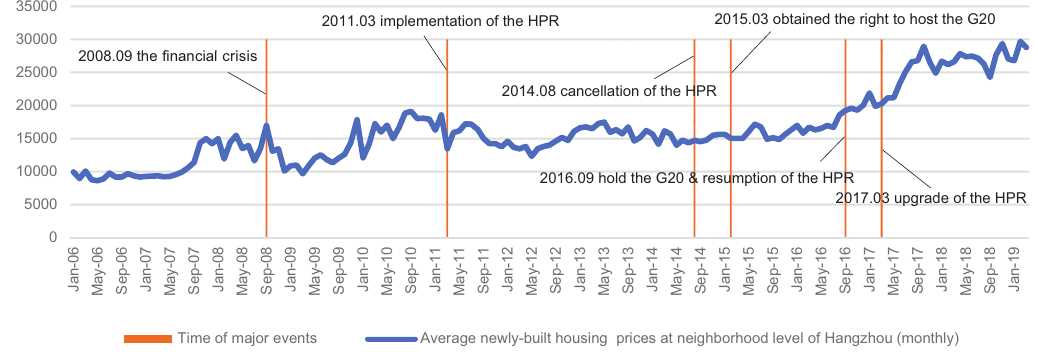
Figure 1. Monthly average housing prices and major events in Hangzhou (from the China Real Estate Information Corporation) Table 1. Descriptive statistics of